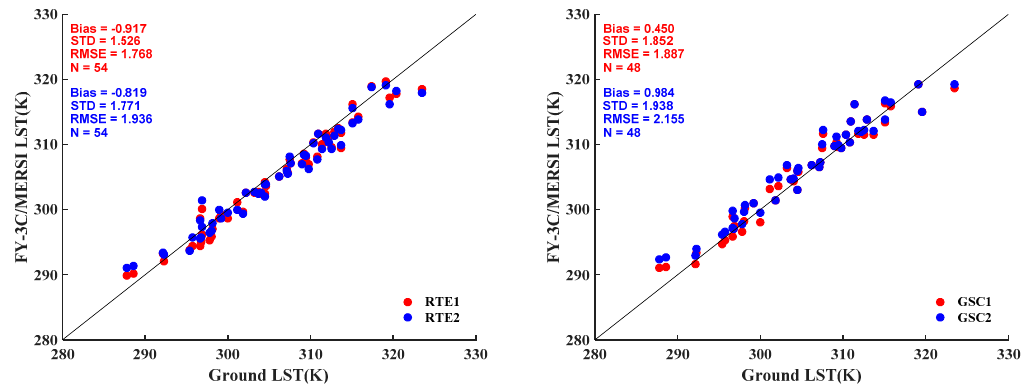
Figure 7. Scatterplots between estimated LST from RTE algorithm (left) or GSC algorithm (right) and in situ LST.